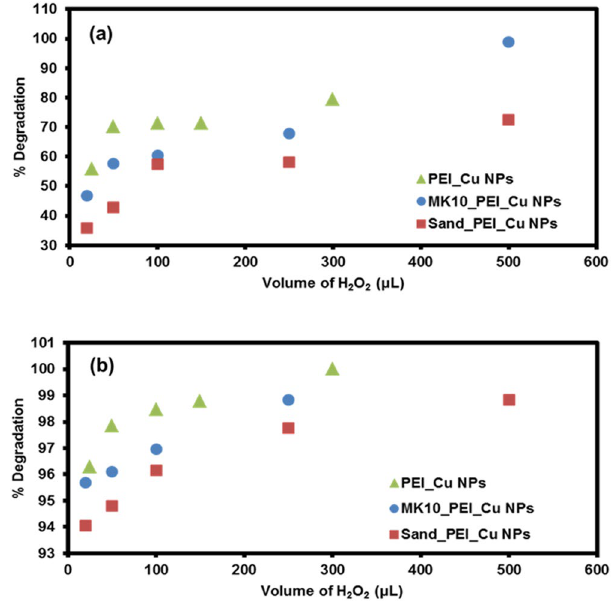
Figure 4. Influence of hydrogen peroxide on degradation of atrazine with modified MK10 and sand at two different equilibrium times: ( a ) 15 h, and ( b ) 1 h.